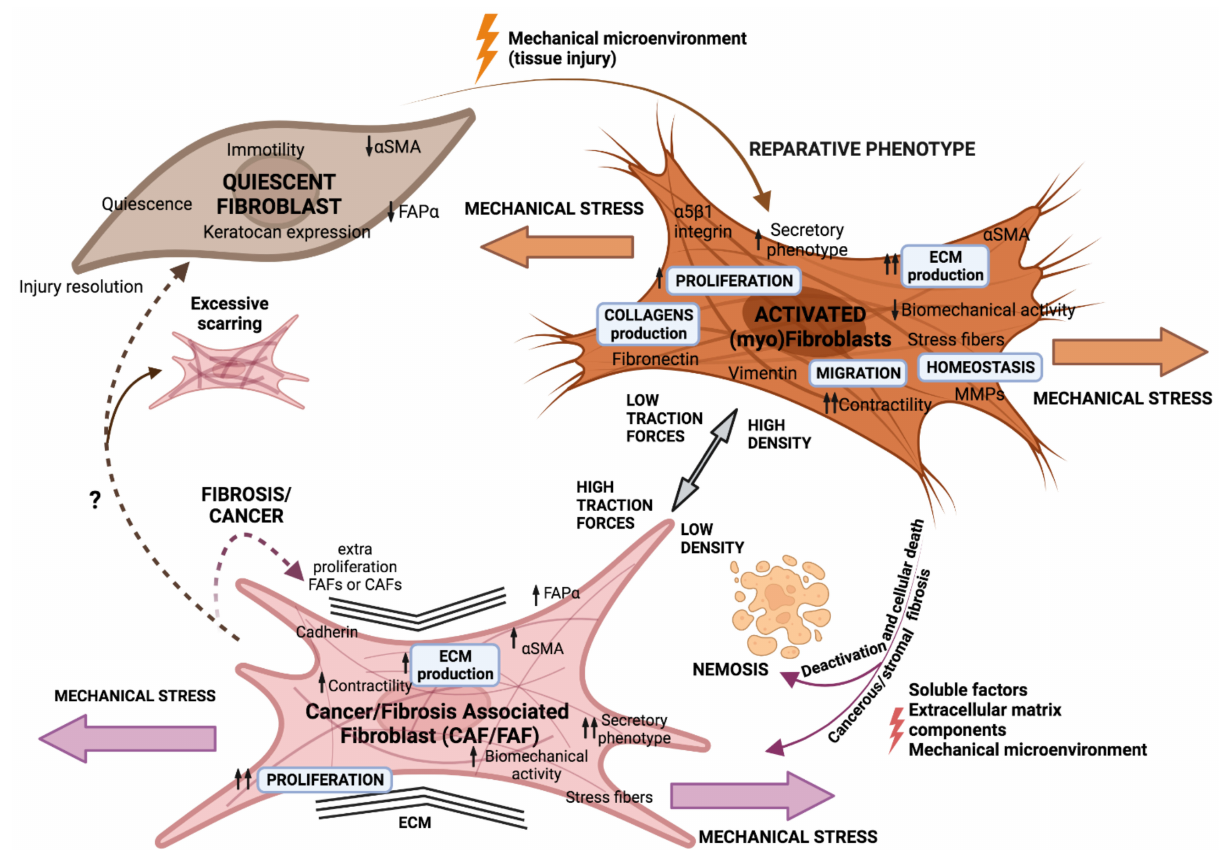
Figure 1. Fibroblasts’ phenotype adapts in response to external aggression. Activation of quiescent fibroblasts to a myofibroblast phenotype to repair tissue damage by wound healing is triggered by microenvironmental signals. Myofibroblasts should disappear by apoptosis (nemosis) after punctual ag- gression, but if fibroblasts are subjected to constant stress, they could evolve into a FAF or CAF